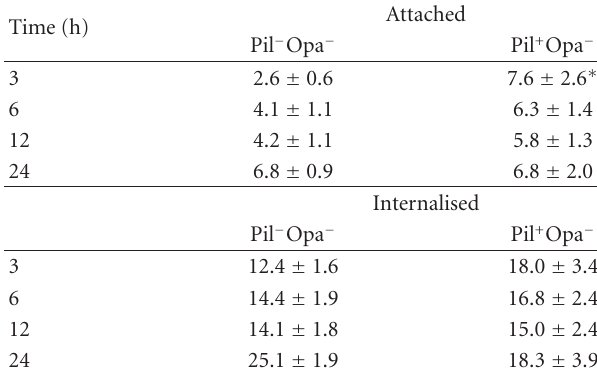
Table 1: Attachment of NGO variants to human FT explant epithe- lium. FT explants were infected with Pil − Opa − NGO ( n = 7) and Pil + Opa − ( n = 6), and 16 fields were examined for each ex- plant at each time point. In each field, gonococci were counted within a continuous epithelial strip of at least 150 cells. The data are presented as the mean and SEM of the number of gonococci observed, attached, or internalized. ∗ denotes a significantly ( P < 0 . 05) higher number of attached Pil + Opa − NGO compared to the Pil − Opa − variant at 3